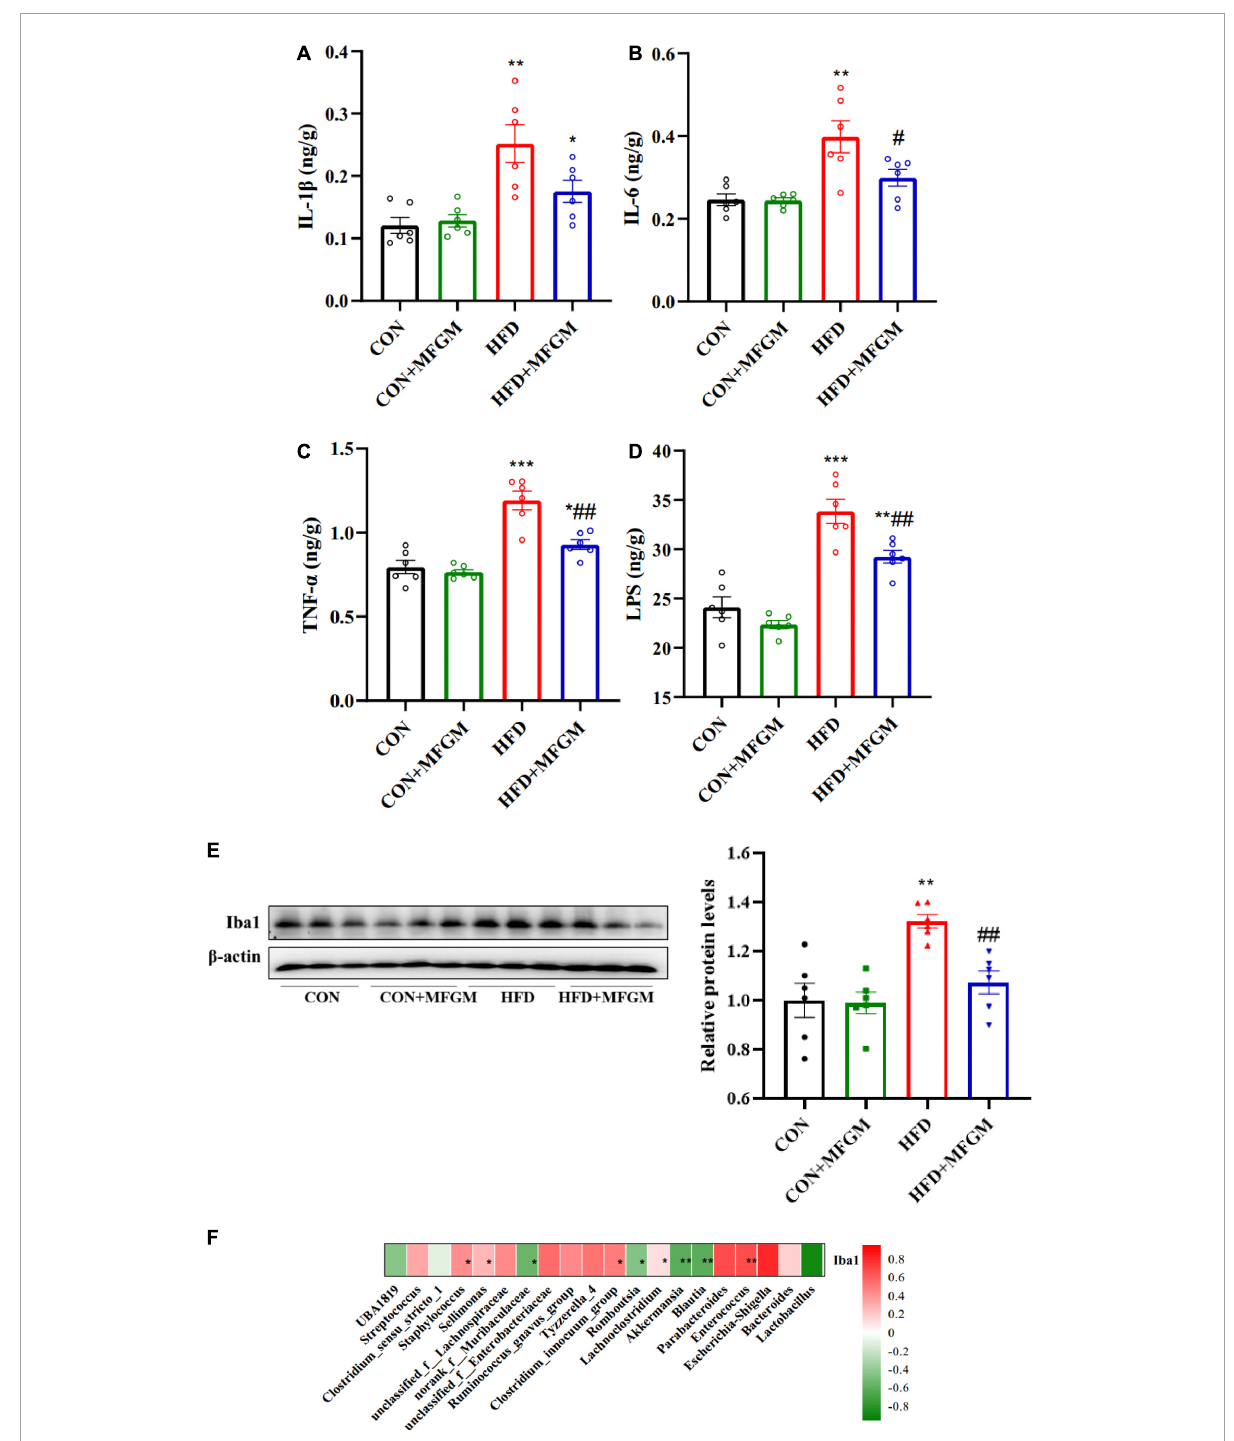
FIGURE6 Maternal supplementation with milk fat globule membrane during pregnancy and lactation alleviated neuroinflammation in weaned offspring from HFD dams. IL-1 β (A) , IL-6 (B) , TNF- α (C) and LPS (D) levels in the brain. (E) Representative image and relative quantitative analysis of Iba1 in the brain by Western blot. (F) Heatmap of Spearman’s correlation between gut microbiota (the 30 most abundant species at the genus level) and Iba1. Values are mean ± SEM, n = 6. * P < 0.05 vs. CON group. # P < 0.05 vs. HFD group. ** P < 0.01 vs. CON group. ## P < 0.01 vs. HFD group. *** P < 0.001 vs. CON